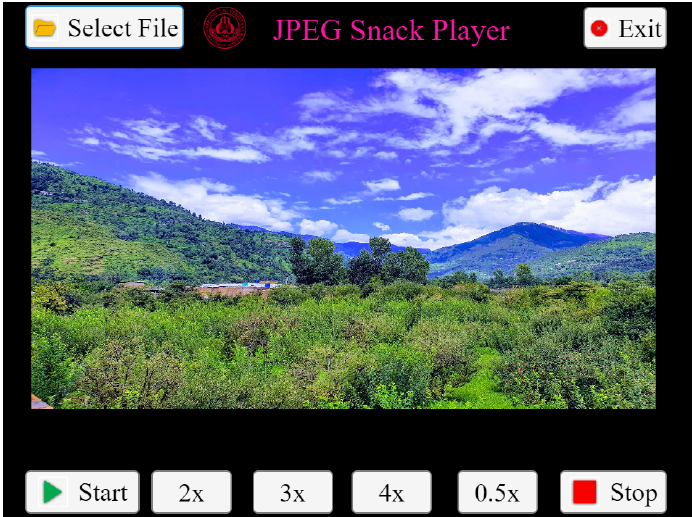
Figure 7. When a JPEG Snack file is selected by the